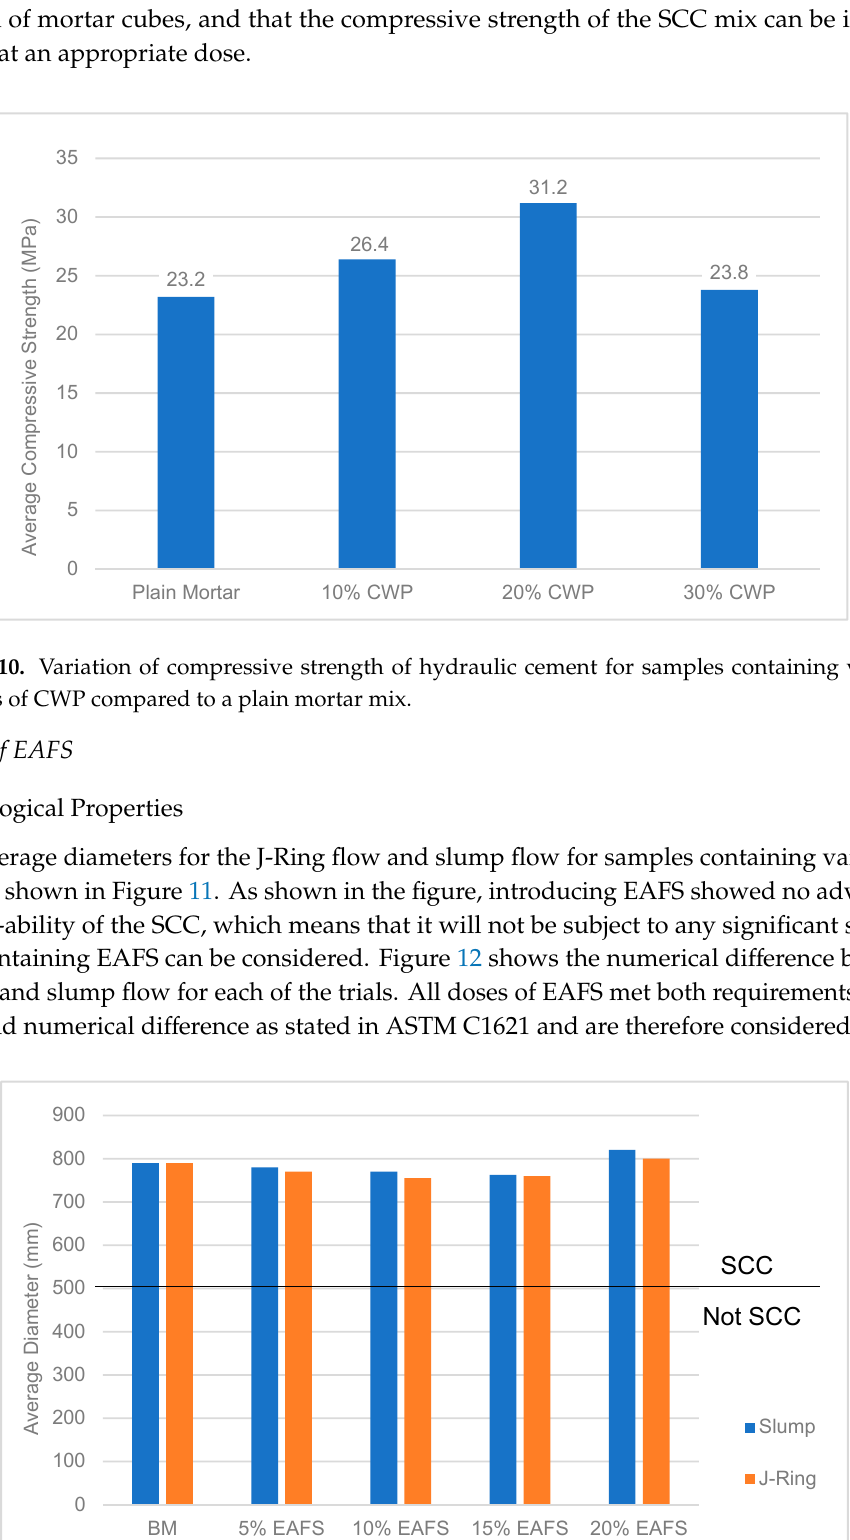
Figure 12. Numerical difference of the J-Ring flow and slump flow for SCC samples containing varying doses of EAFS. Introducing EAFS had no effect on the flow-ability of the SCC. All samples of SCC had ideal flow-ability as their H2/H1 ratio was 1.0. This, along with the J-Ring test results, show that introducing EAFS to a benchmark SCC mix at these doses does not undermine its rheological properties. Figure 13 shows the time it takes for samples containing different doses of EAFS to pass through a V-Funnel. It is clear that adding EAFS to a benchmark SCC mix significantly decreases its viscosity. A small dose of EAFS reduced the time required to clear the V-Funnel to 1 s, compared to 15 s for the benchmark SCC mix. All doses up to and including 15% EAFS were at or under the maximum desirable time stated in BS EN 12350-9 [18]. The results from this test shows a strong correlation between the EAFS content in a sample of SCC and its viscosity. The results of the 5, 10, and 15% replacements stand at odds with the findings of another study, which stated that the incorporation of EAFS would significantly increase the viscosity of the SCC mix [10].